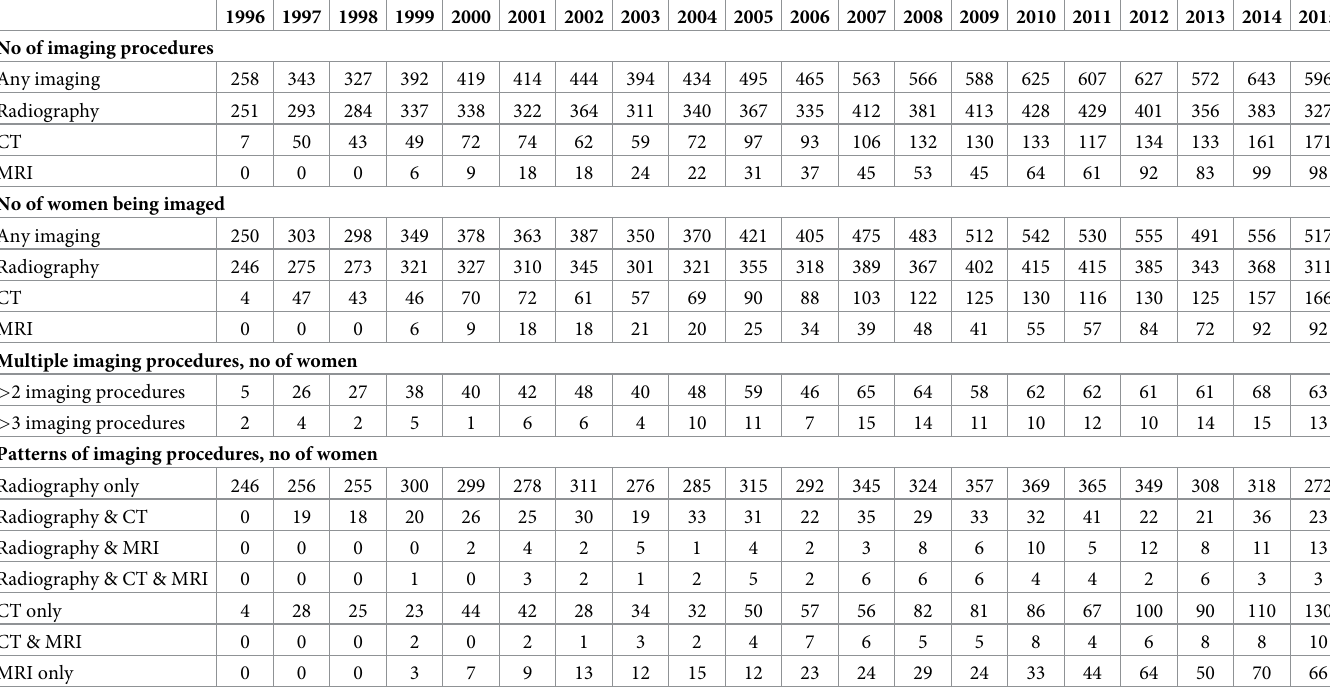
Table 1. Annual lumbar spine imaging from 1996 to 2015 among 13458 women.